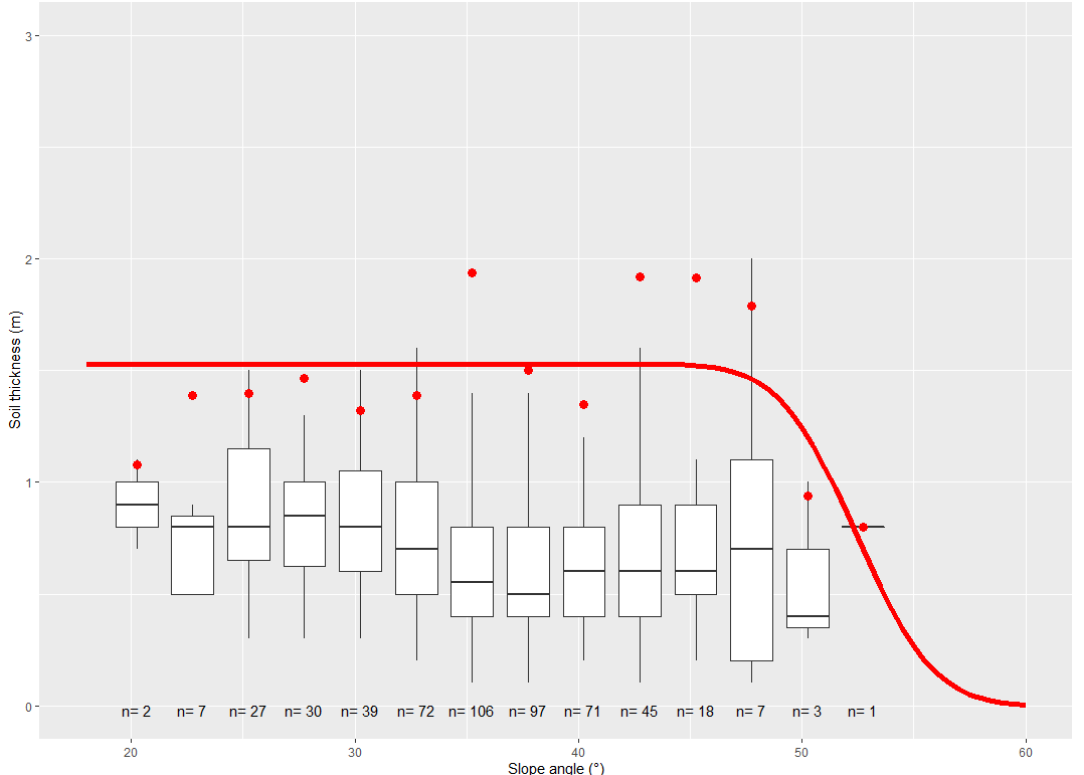
Figure A2. Shallow-landslide slope–soil thickness relationship as used in this research. Box plots are classes with a width of 2.5 slope units. The red dots are the 95th percentile per class. The red line is the fit of Eq. (7) to the 95th percentiles.